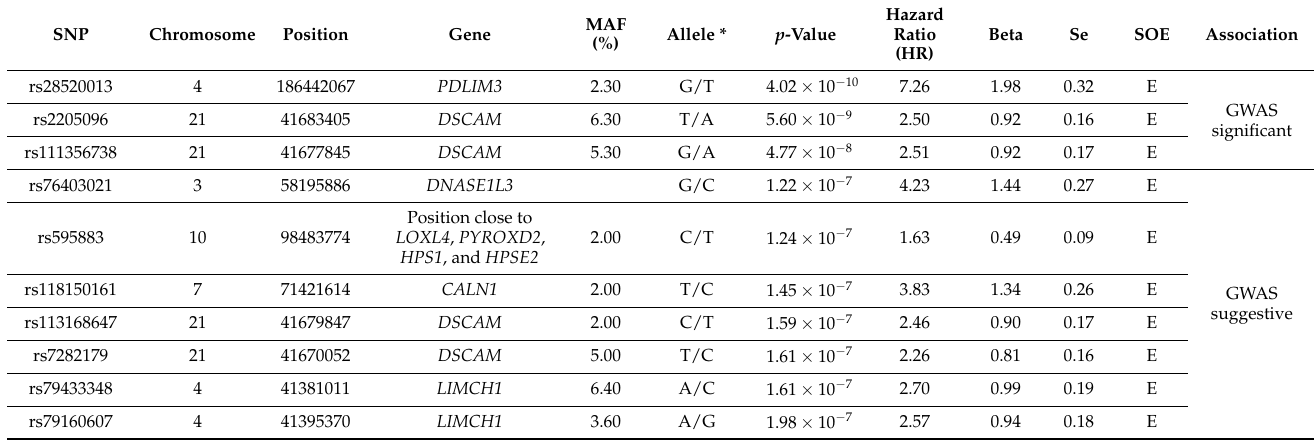
Table 2. GWAS significantly or suggestively associated SNPs with PFS from the